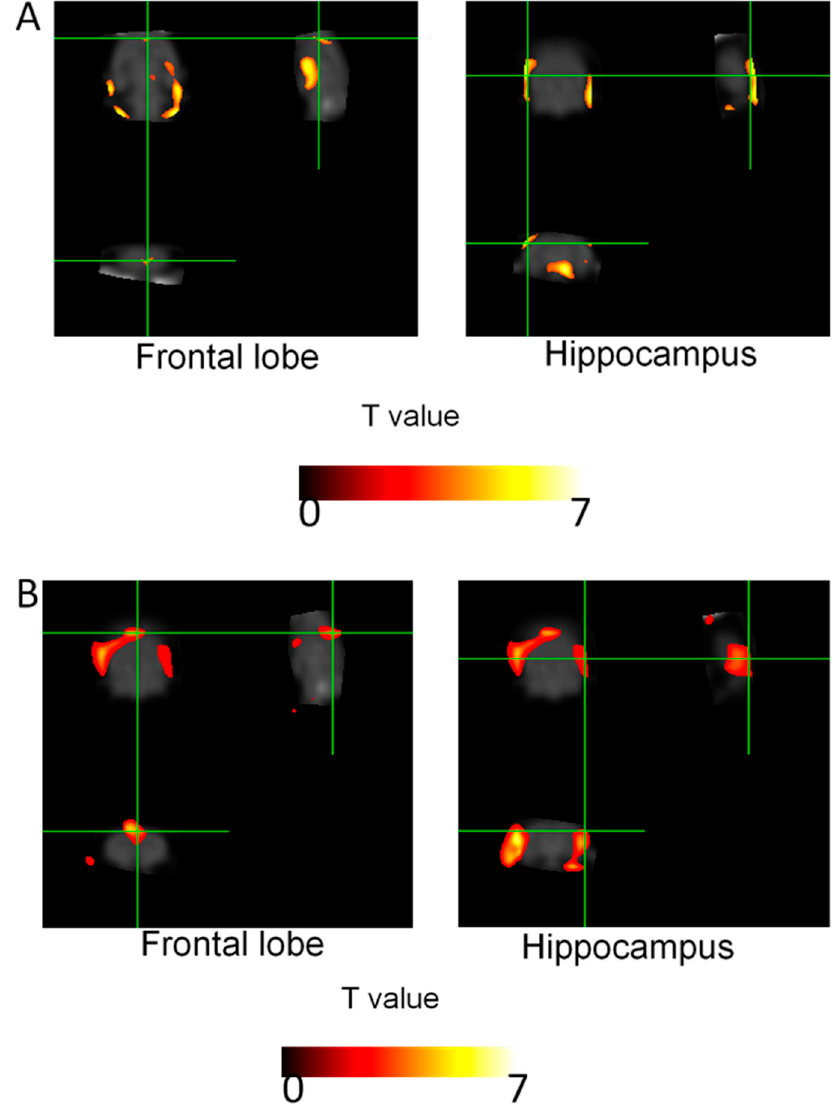
Figure 5. Brain regions showing regional glucose metabolism. ( A ) Brain regions where the regional 18 F-fluodeoxyglucose (FDG) uptake in the TMT group ( N = 3) was markedly lower than in the normal group ( N = 3) (hippocampus and frontal lobe). ( B ) Brain region where reginal glucose uptake in the TMT + Bean-PS group ( N = 3) was significantly higher than in the TMT group (frontal lobe and hippocampus). Green line: cross hair Table 1. The changes of Z values in the hippocampus and frontal lobe. The results of voxel-wise comparison between the TMT + Bean-PS and TMT group datasets are shown (Table 1A). In the statistical parametric mapping (SPM) analysis, the cerebral glucose uptake of TMT+Bean-PS datasets was significantly increased in the hippocampus and frontal lobe compared with that of the TMT group (Table 1B).